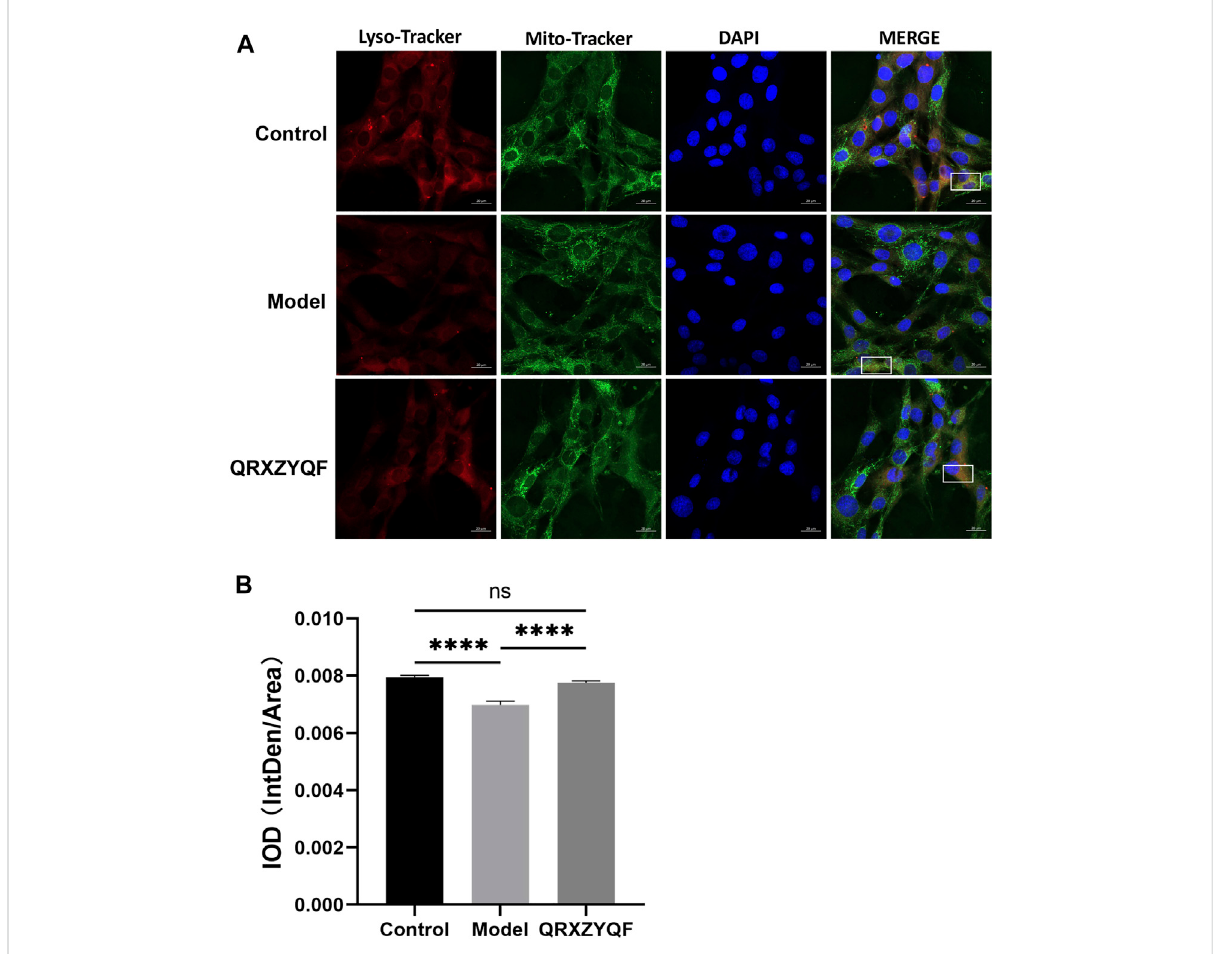
FIGURE 9 Representative immuno fl uorescence co-localization images of mitophagy in MPC5. (A) Representative images showing mitophagosomes (yellow puncta) in MPC5. Lysosomes and mitochondria were labeled with Lyso Tracker Red and Mito Tracker Green, respectively (scale bar: 20 μ m); (B) IOD values of immuno fl uorescence co-localization evaluating mitophagy in MPC5. ns P > .05, **** p <